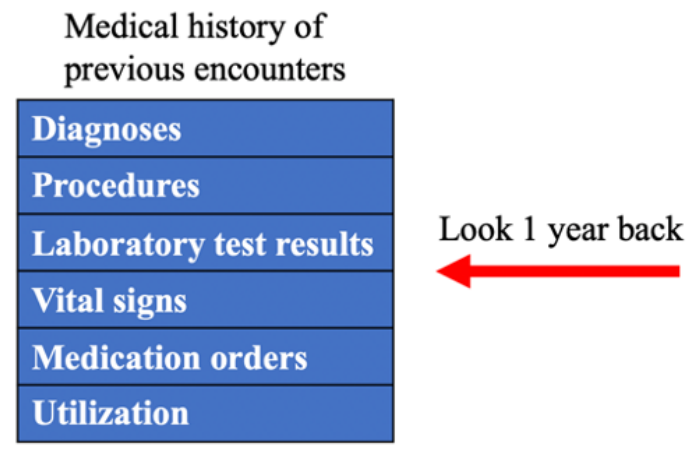
Figure 1. The variables used to develop the